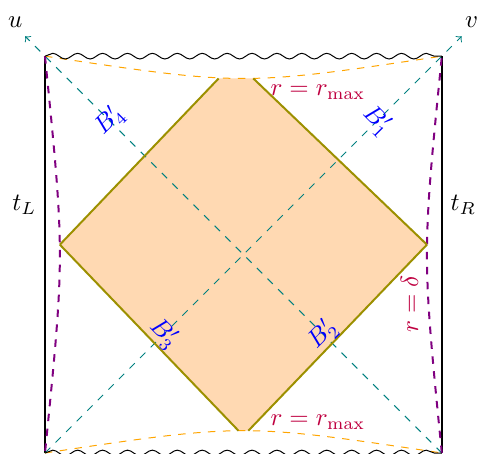
c . Note that we choose the